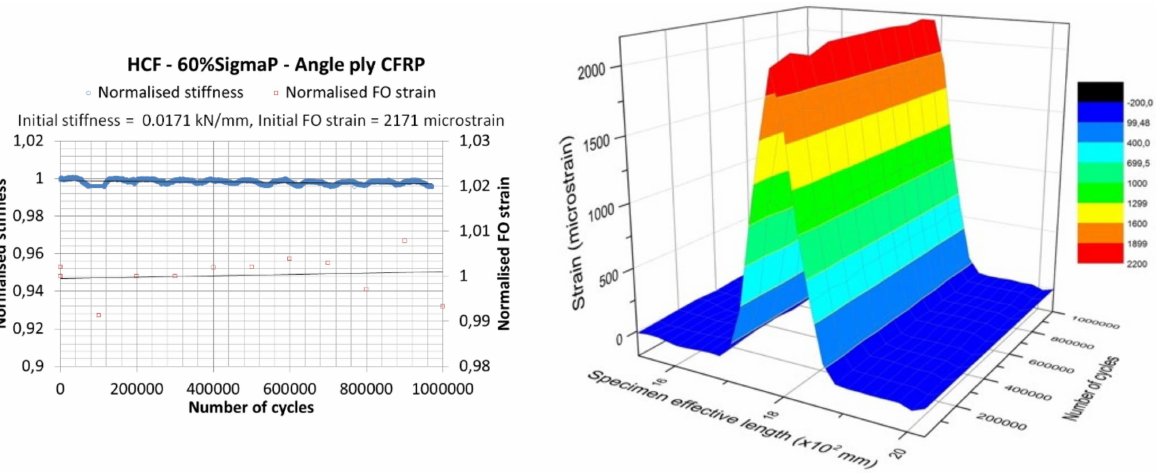
Figure 23. HNCF test curve corresponding to a maximum stress 0.6 σ p in angle-ply smart specimen along with corresponding 3-D HCF test